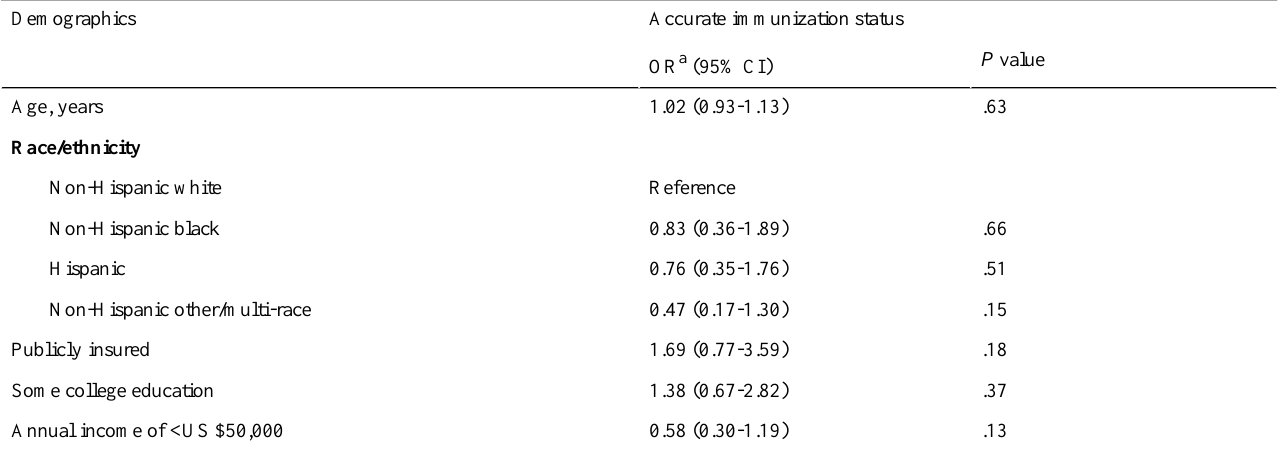
Table 4. Association between characteristics of subjects and the accuracy of self-report.